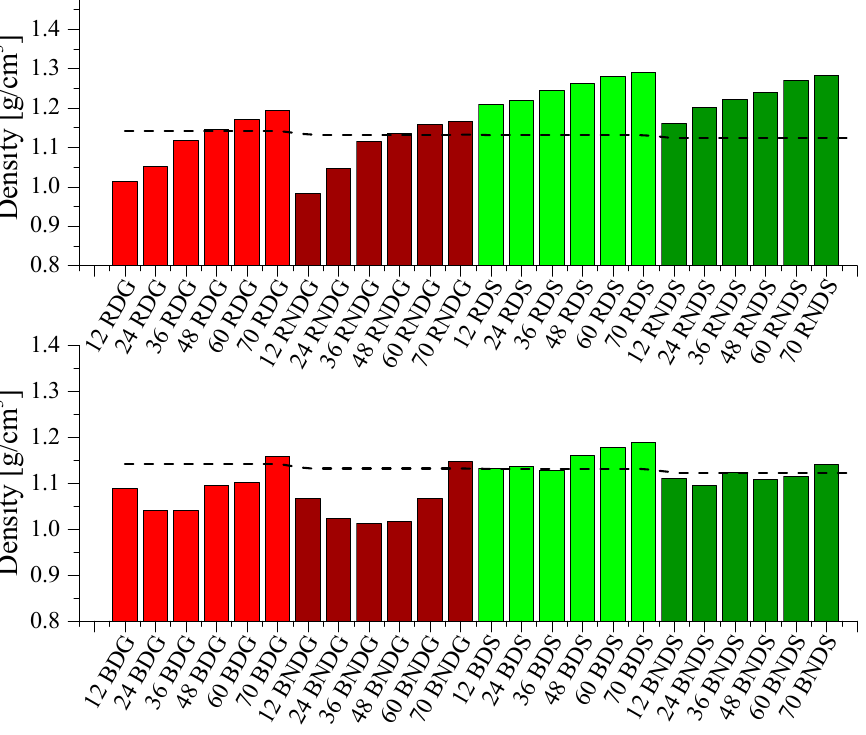
Figure 11. Density of degassed and non-degassed composites containing base diatoms and rinsed diatoms.